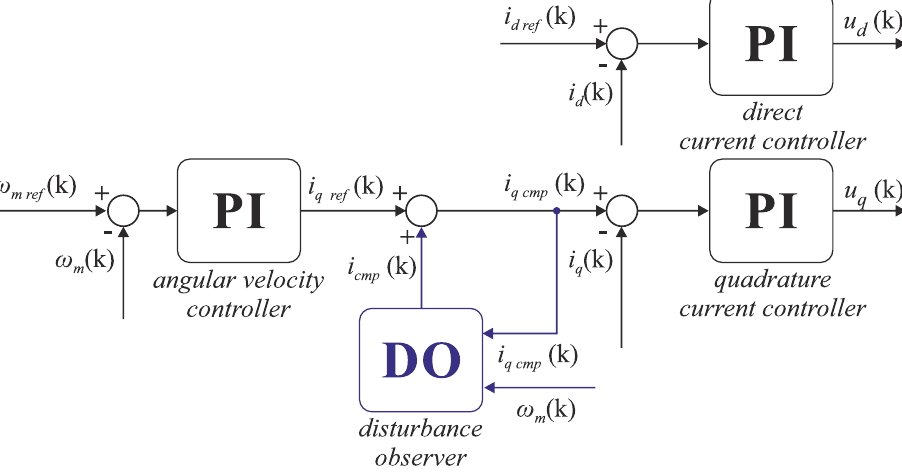
Figure 5. Block diagram of investigated cascade control structure with disturbance observer. Table 3. Controller coefficients for CCS and